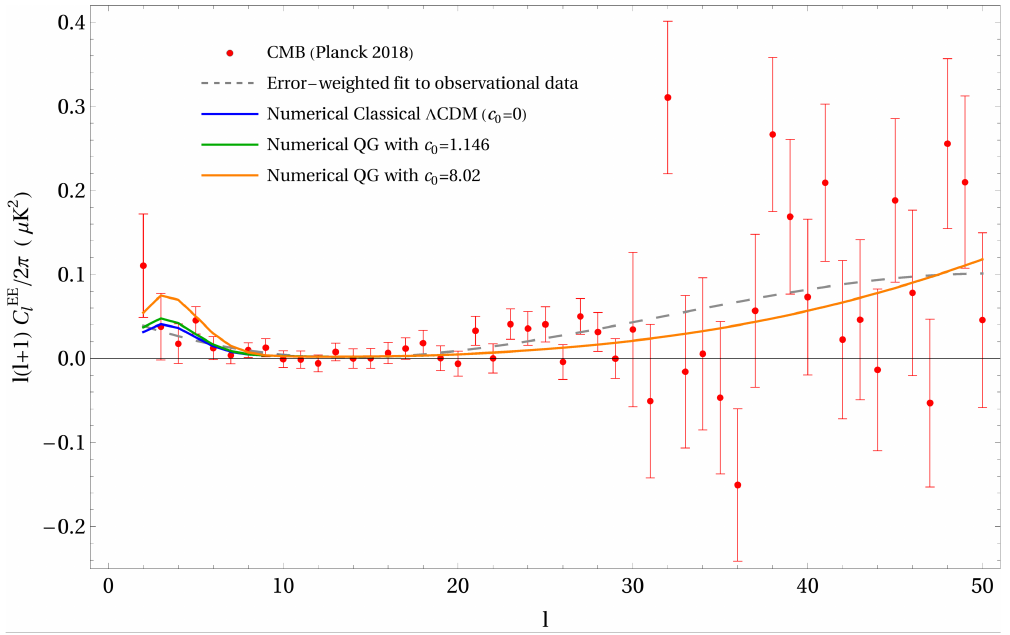
Figure 6. Comparison of the numerical prediction of the classical Λ CDM program vs. the numerical predictions of the RG running of Newton’s constant’s effect on the E-mode (EE) power spectrum C EE The solid curves represent the numerical predictions generated by ISiTGR, with the bottom (blue), middle (green) and top (orange) representing quantum amplitudes quantum amplitudes (see Equation (9)) c 0 = 0,1.146,8.02, respectively, showing slightly higher trends for large angular scales ( l < 10) as compared to the classical (no running) numerical Λ CDM curve. The dashed curve represents error-weighted cubic fit for observational CMB data from the Planck (2018) collaboration